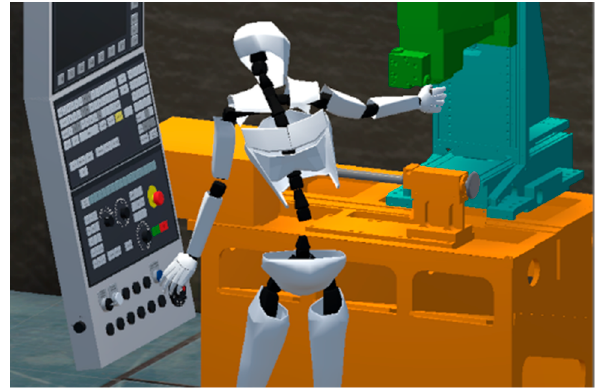
Figure 8. Installing a milling cutter in the machine tool simulation.